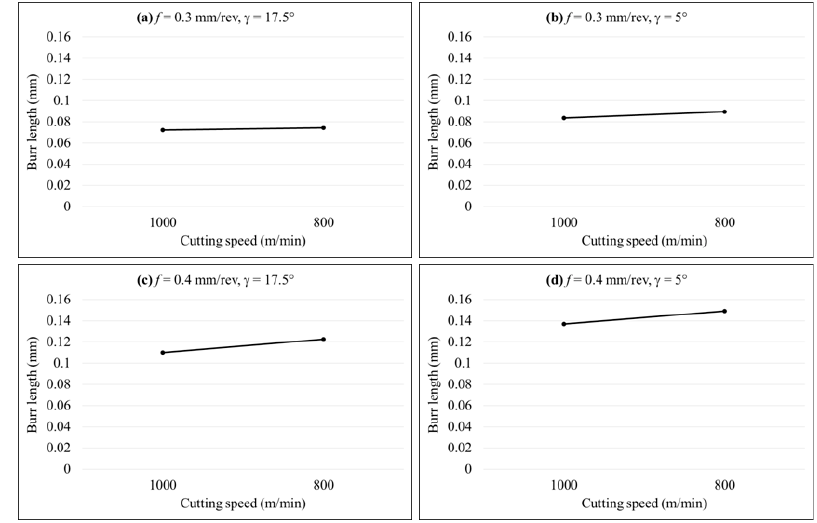
Figure 7. Effect of rake angle on end burr lengths along x-axis at Z = 0 (mid-section along depth of cut) ( a ) V C = 800 m/min, f = 0.3 mm/rev ( b ) V C = 1000 m/min, f = 0.3 mm/rev ( c ) V C = 800 m/min, f = 0.4